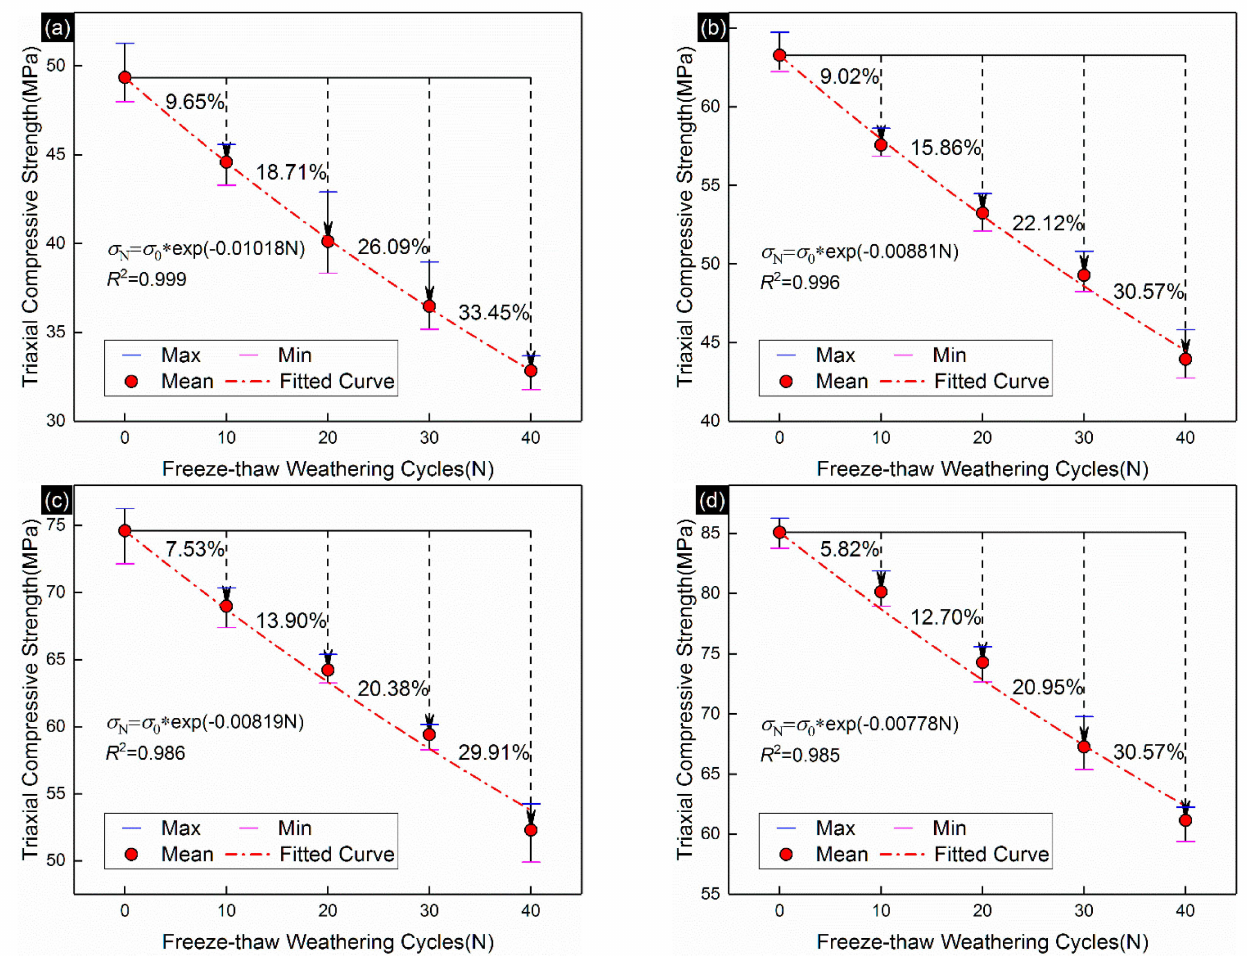
Figure 11. TCS and its reduction ratio for sandstone specimens after undergoing different quantities